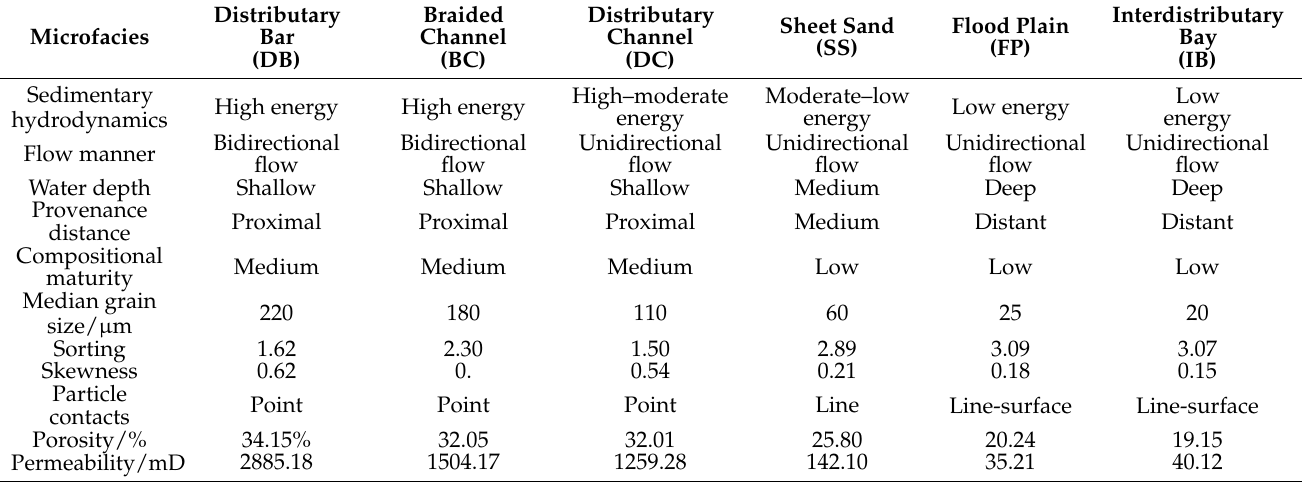
Table 4. Petrological characteristics and sedimentary environment of shallow braided river delta sedimentary microfacies.